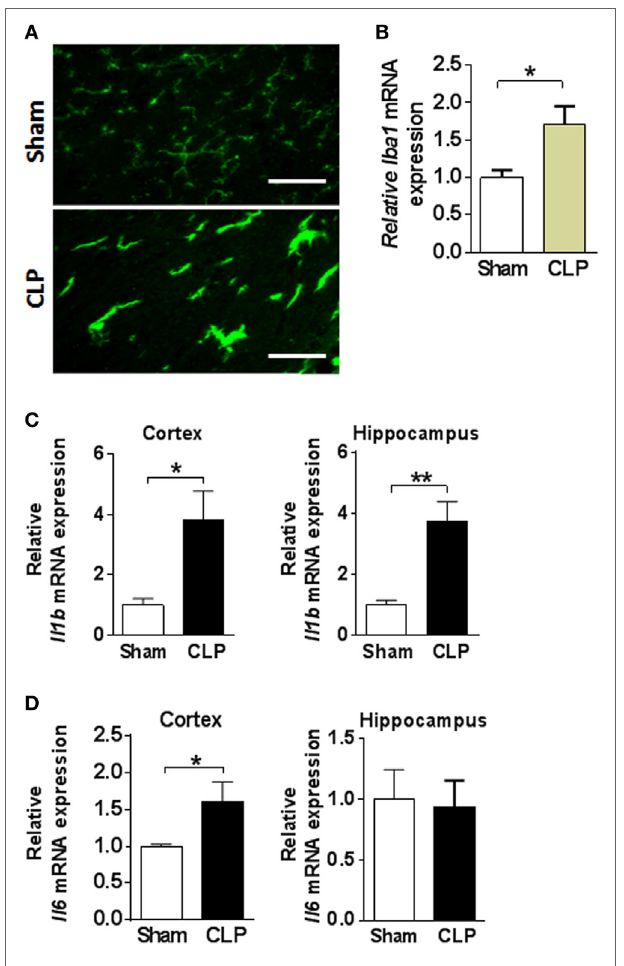
FigUre 5 | Cecal ligation and puncture (CLP) results in neuroinflammation in mouse sepsis survivors. (a) Representative images of Iba1immunostaining in cortex of sham and CLP mice (scale bar = 50 μ m). (B) Iba1 mRNA expression in cortex and hippocampus of sham and CLP mice. * P = 0.0139, Student’s t -test, n = 8 per group. (c) Il1b mRNA expression in cortex and hippocampus of sham and CLP mice. * P = 0.0123, ** P = 0.0011, Student’s t -test, n = 8 per group. (D) Il6 mRNA expression * P = 0.0455, Student’s t -test, n = 8 per